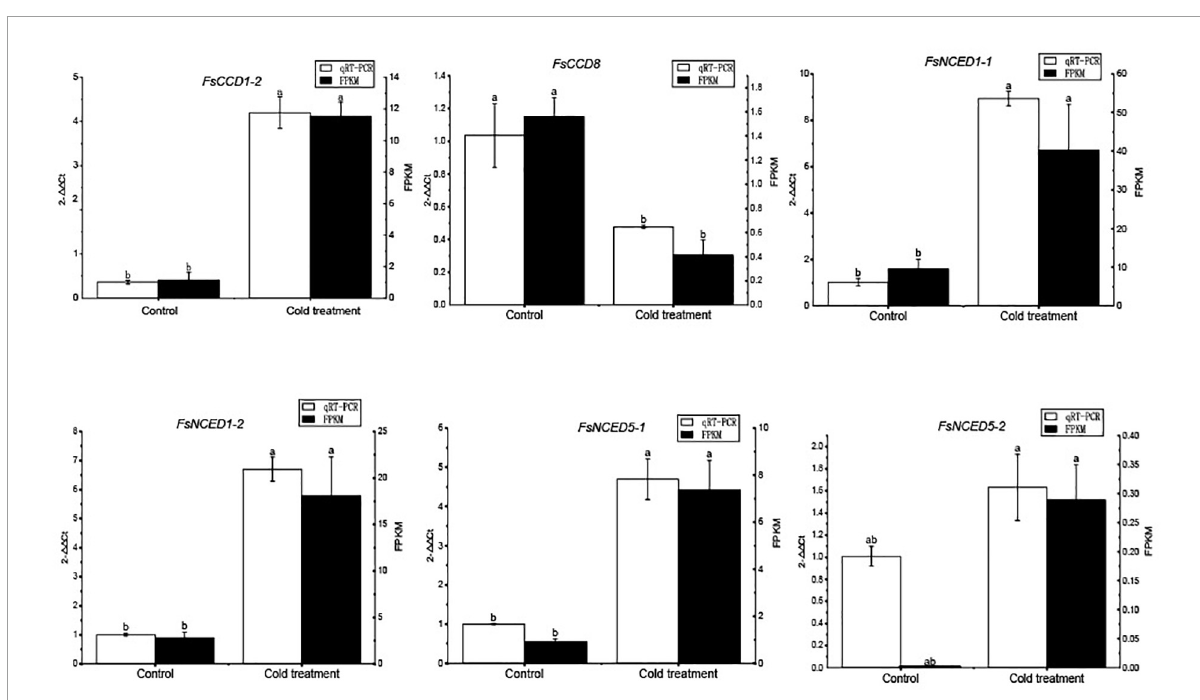
FIGURE9 qRT-PCR verification of the CCD genes of Forsythia suspensa under cold stress. Comparison of q RT-PCR (white bar) with RNA-seq data (black bar). The relative changes were calculated with 2 − (cid:77)(cid:77) Ct . The relative qRT-PCR expression level is shown on the left y -axis. The FPKM from the RNA-Seq data are indicated on the right y -axis. The letters above the bars indicates the significance among different samples.